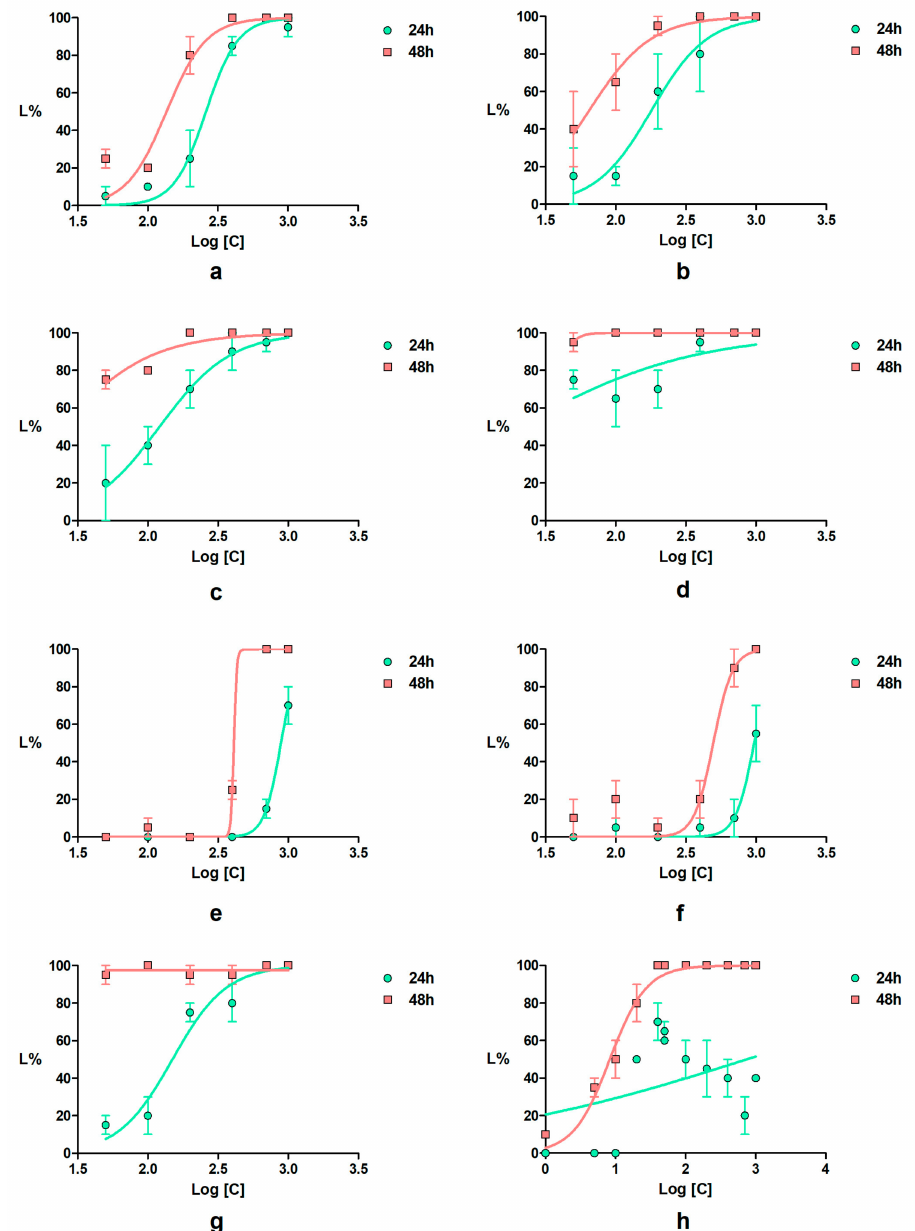
Figure 9. Daphnia magna lethality curves for the tested compounds: ( a )— 13 ; ( b )— 17a ; ( c )— 17b ; ( d )— 17c ; ( e )— 17d ; ( f )— 17e ; ( g )— 17f ; ( h )—nifedipine; error bars represent the standard error of the